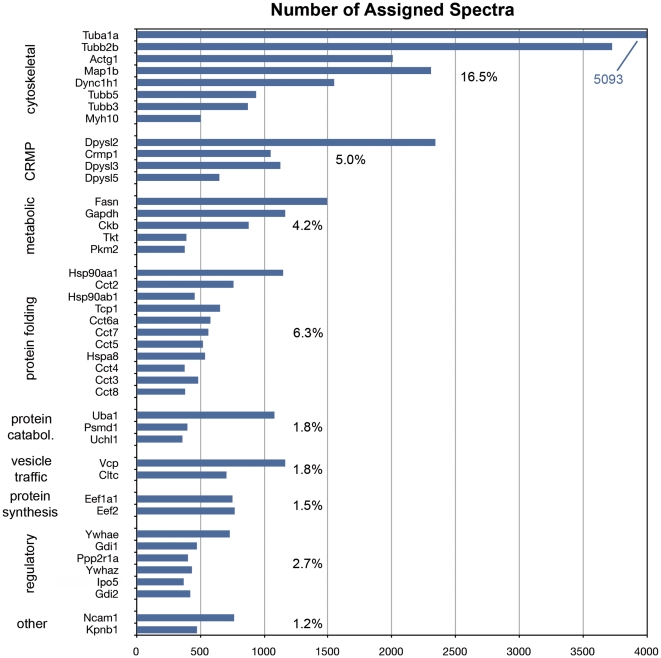
The 43 highest-ranked proteins based on identifying spectra (≥400) detected in the net GCP preparation.The proteins are grouped functionally. CRMP, collapsing response mediator proteins. Percent values indicate the cumulative number of spectra identifying the proteins shown in each group relative to the total number of spectra detected in growth cones.